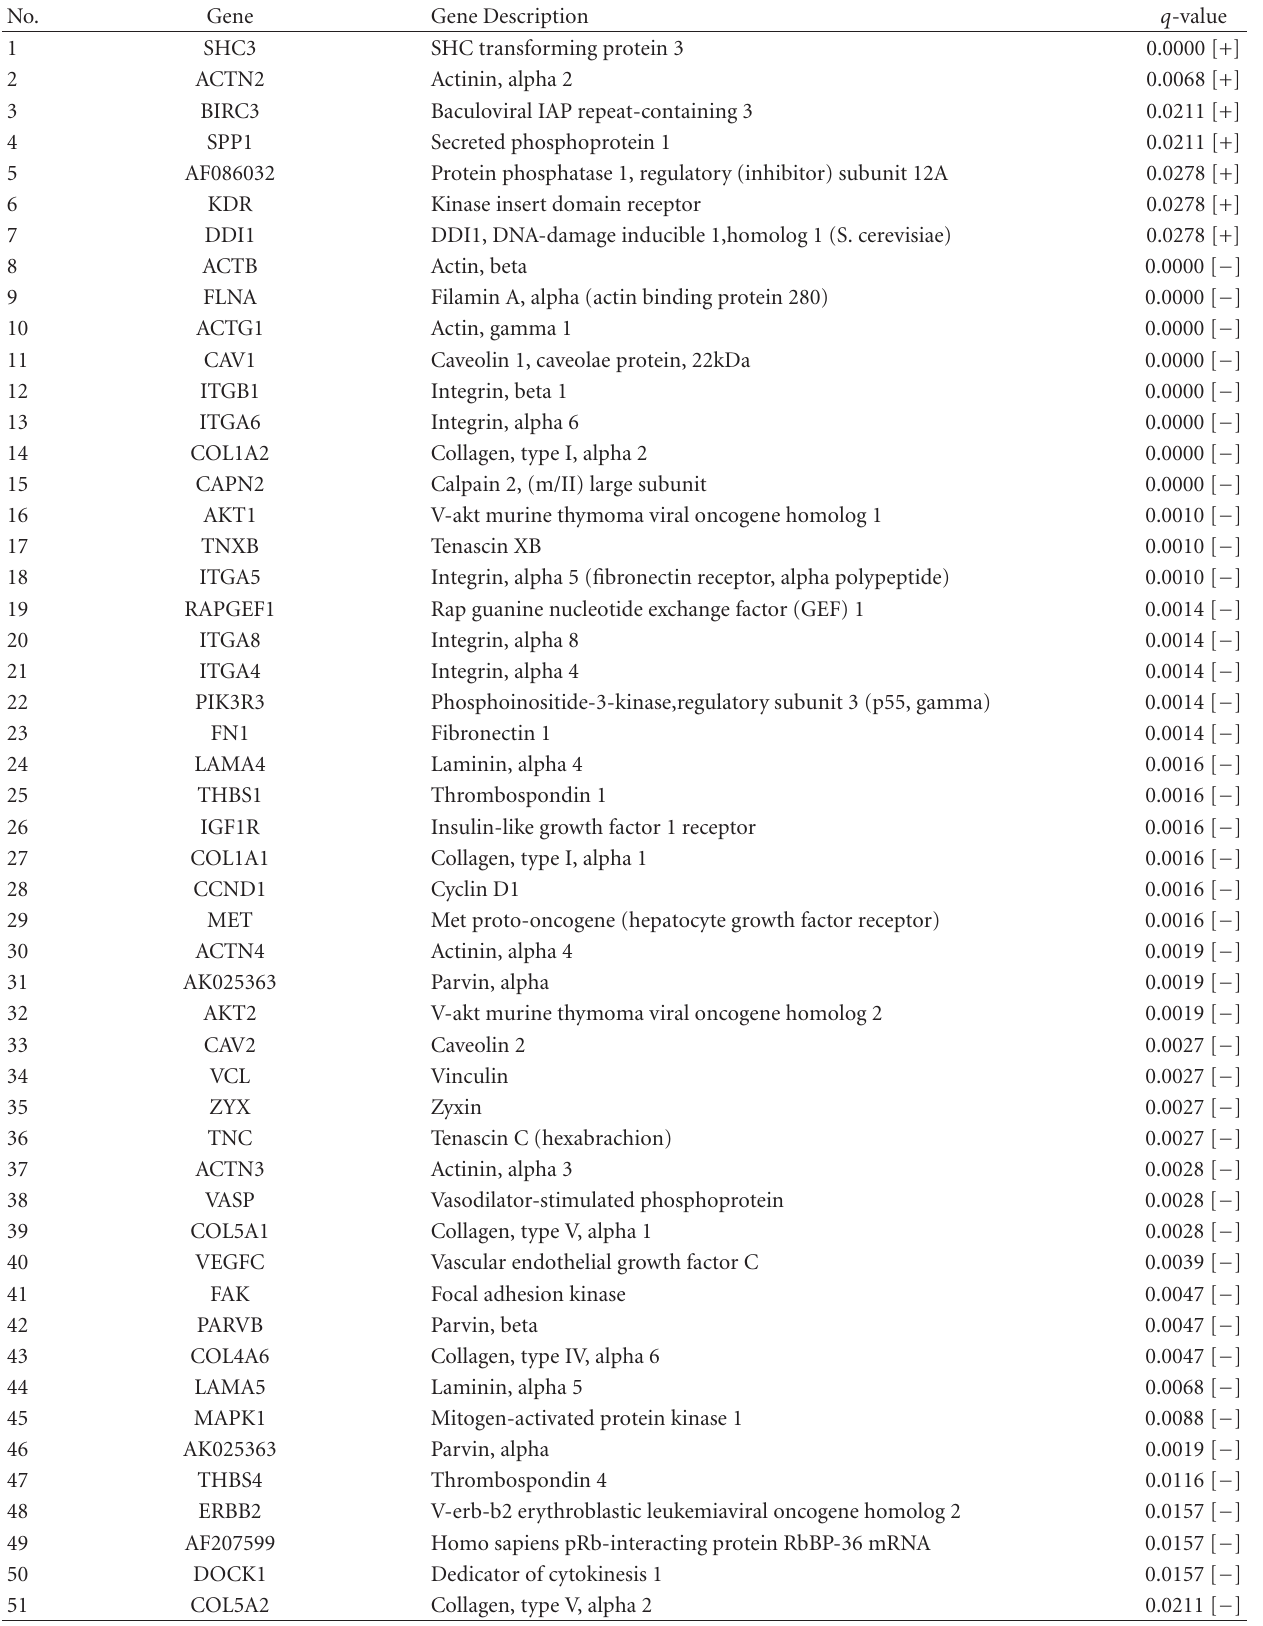
Table 2: Gene names, gene descriptions, and significance analysis results of mapped genes in focal adhesion pathway obtained via SAM analysis, where “[]” showed upregulated (+) or downregulated ( − ) by rCFES treatment at q -value <